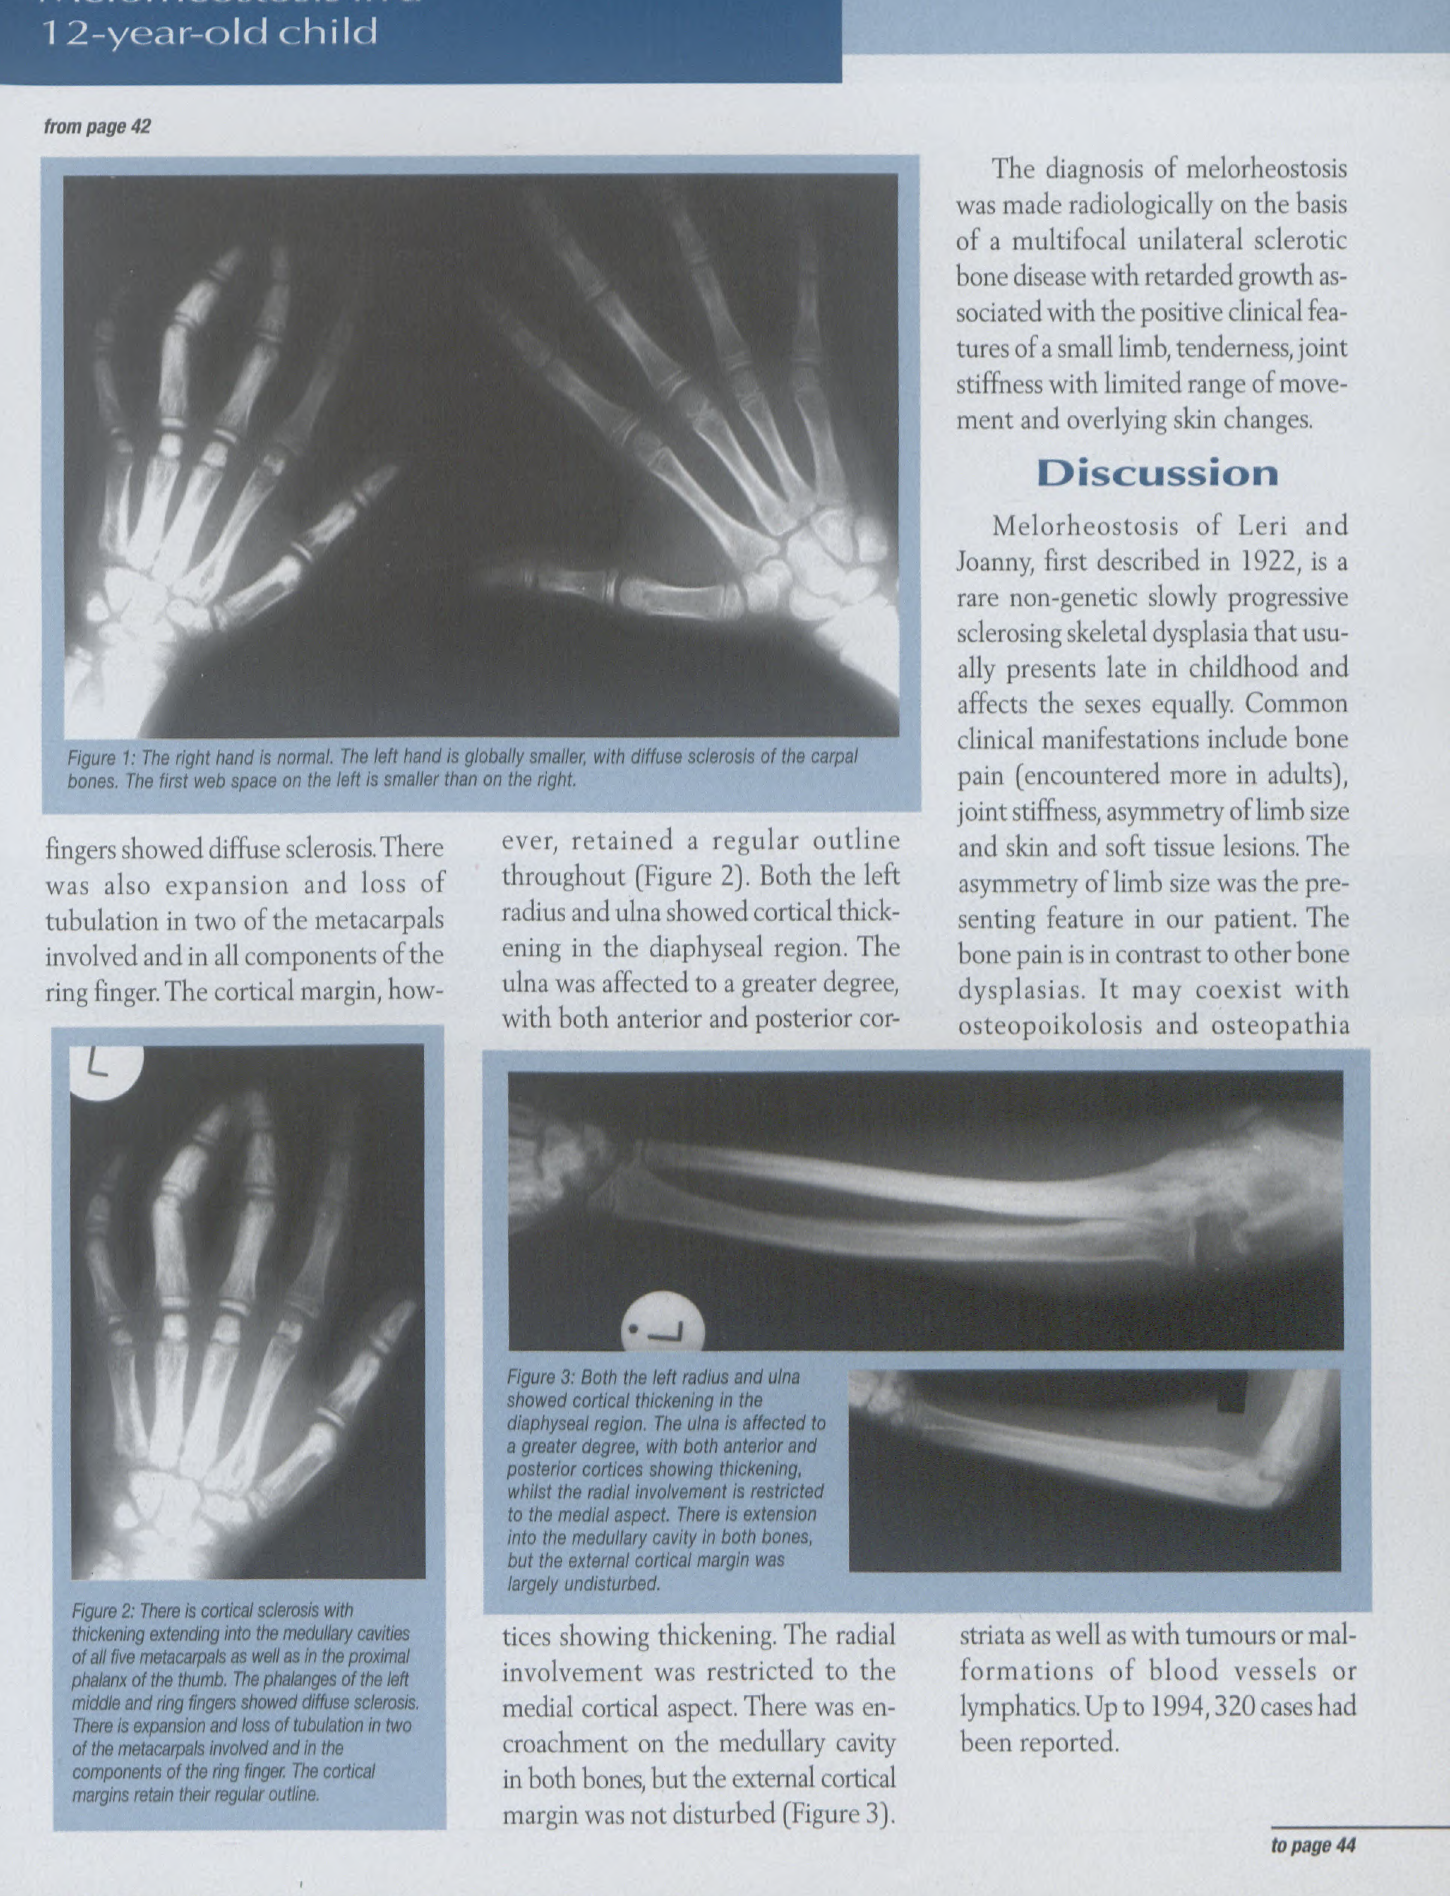
Figure 3: Both the left radius and ulna showed cortical thickening In the diaphyseal region, The ulna is affected to a greater degree, with both anterIor and posterior cortices showing thickening, whilst the radIal Involvement is restricted to the medial aspect. There is extension into the medullary cavity in both bones, but the external cortical margin was largely undisturbed, tices showing thickening. The